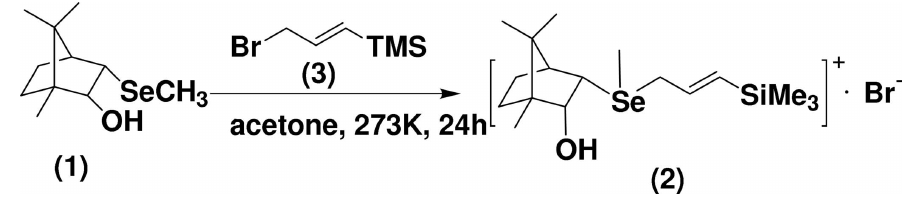
Figure 3 Reaction